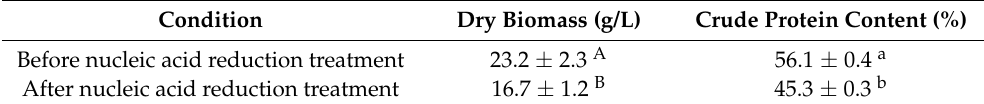
Table 4. Dry weight and protein content of dry biomass before and after nucleic acid treatment. Condition